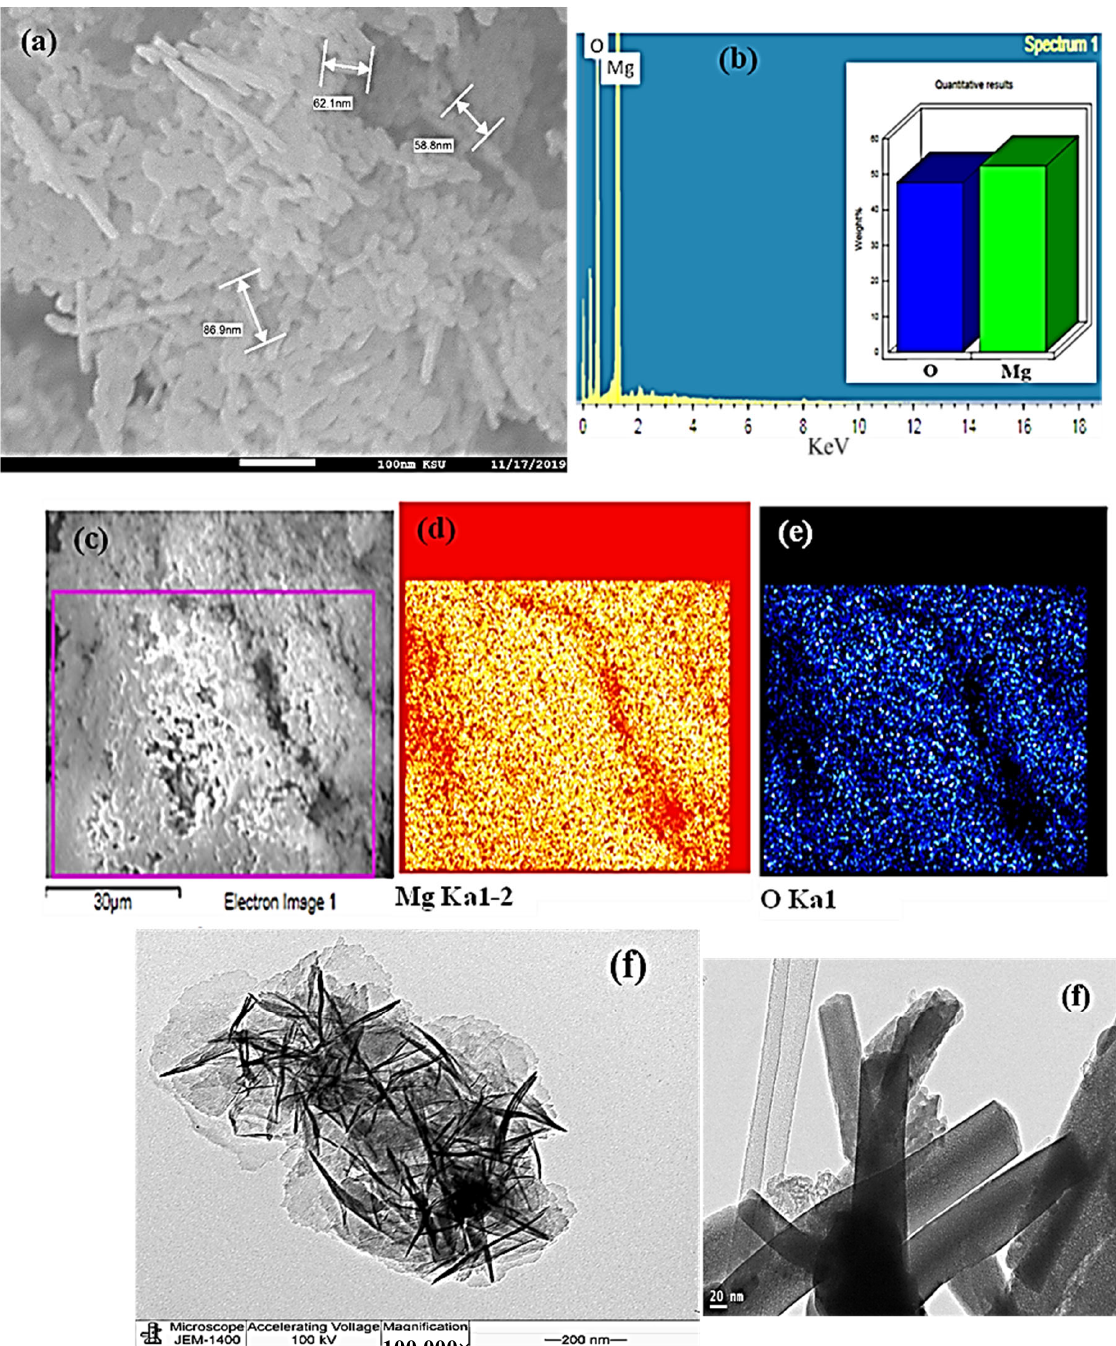
Figure 3. SEM image ( a ), EDX spectrum of MgO ( b ); and X-ray elemental mapping of Mg − Ka ( d ) and O − Ka ( e ) of the SEM MgO selected area ( c ), and TEM image ( f ).